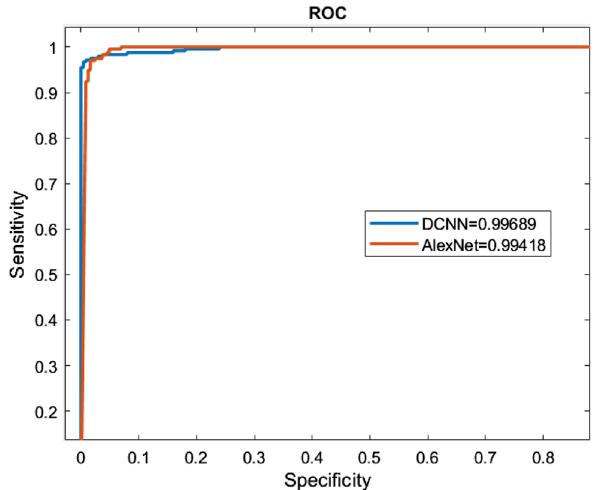
Fig. 7 ROC curves of DCNN and AlexNet